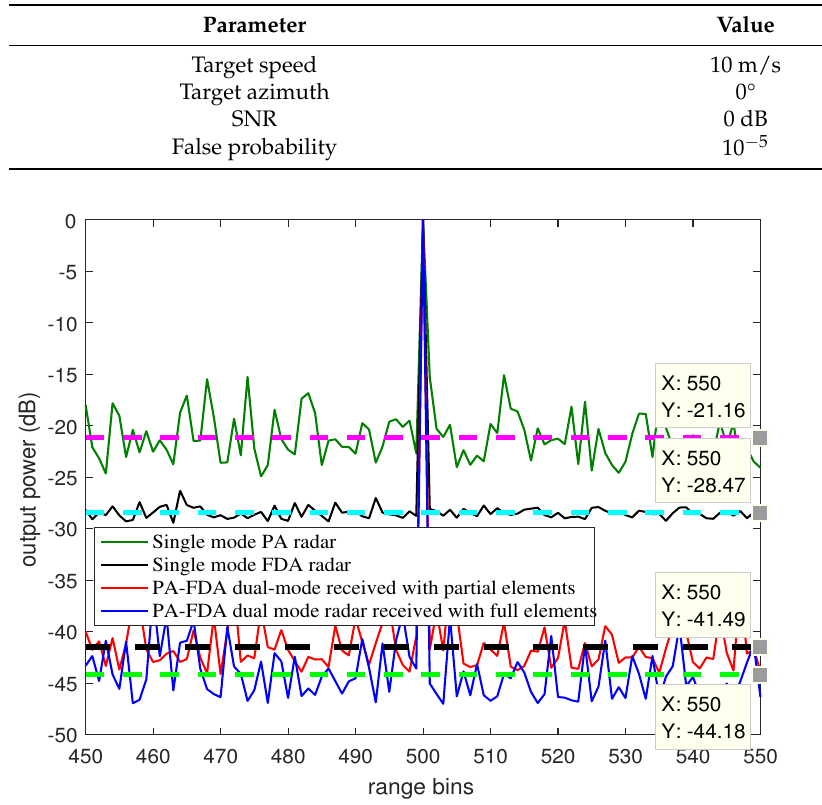
Figure 9. Target SCNR output